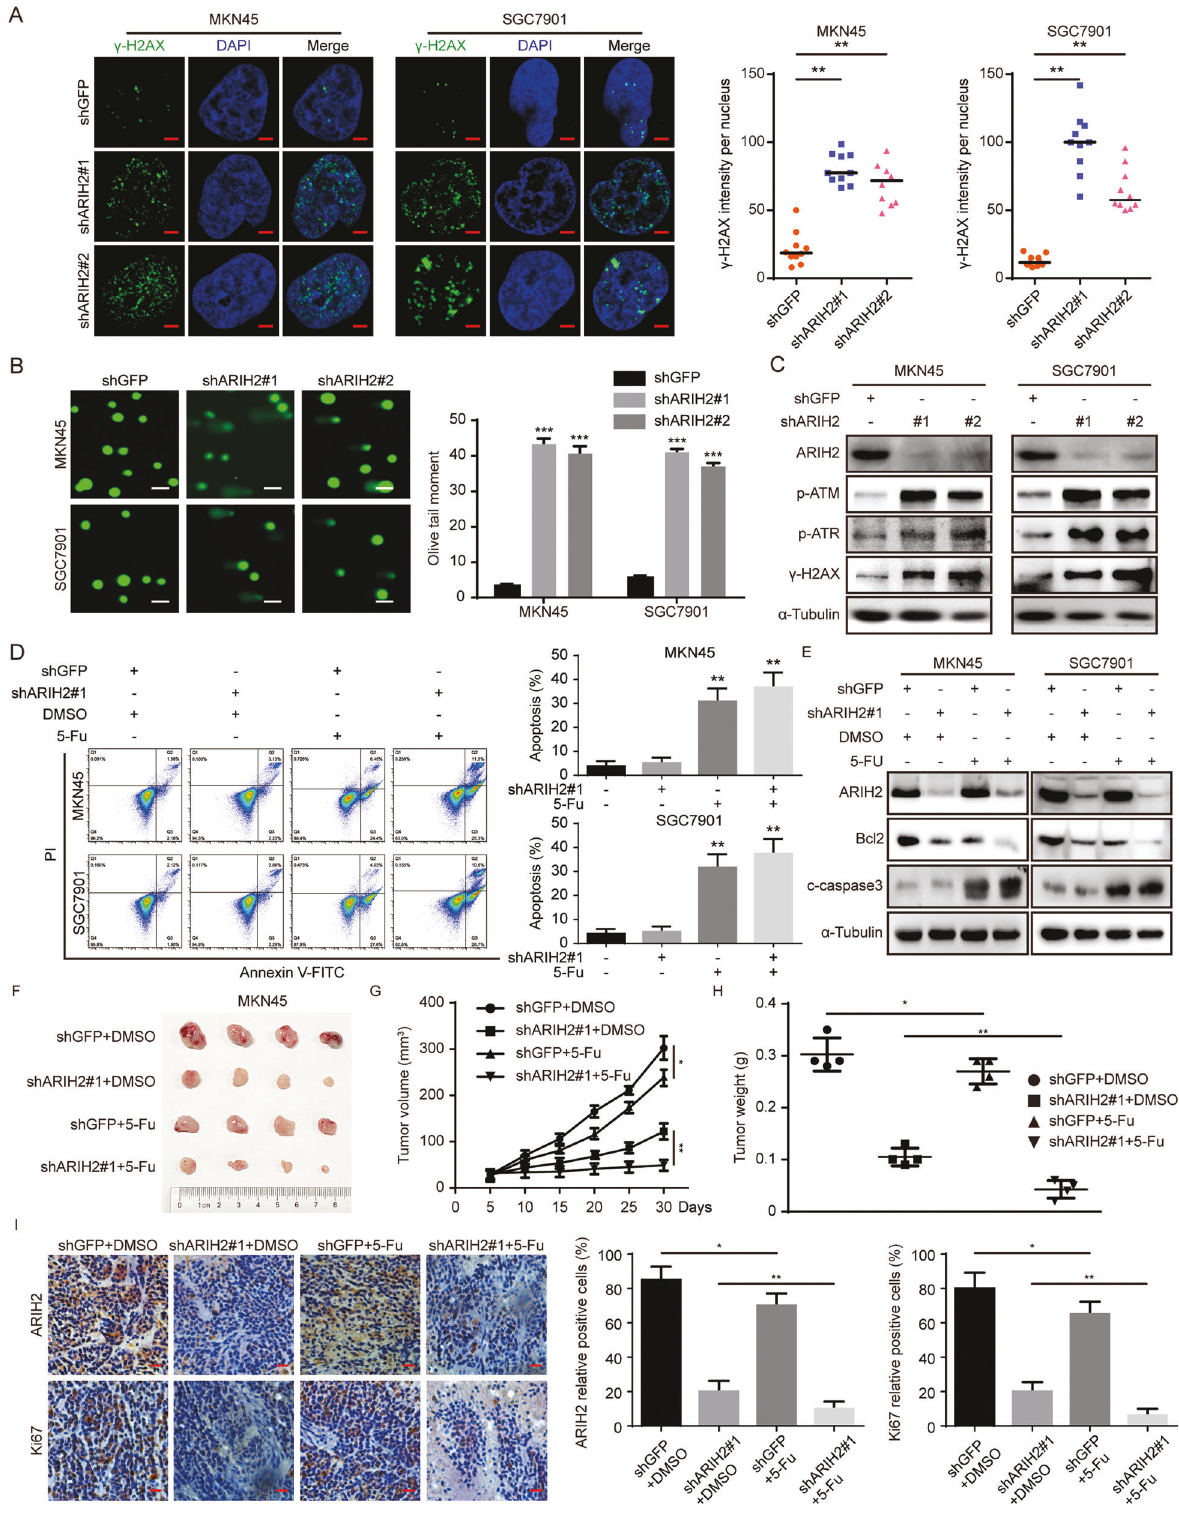
knockdown signi fi cantly induces DNA damage (Fig. 6B). Western blot assays were further used to verify the role of ARIH2 in DNA damage, showing that the expression of the DNA damage-related proteins phosphorylated(p)-ATM, p-ATR and ɣ -H2AX was signi fi - cantly increased after ARIH2 knockdown (Fig. 6C). To con fi rm